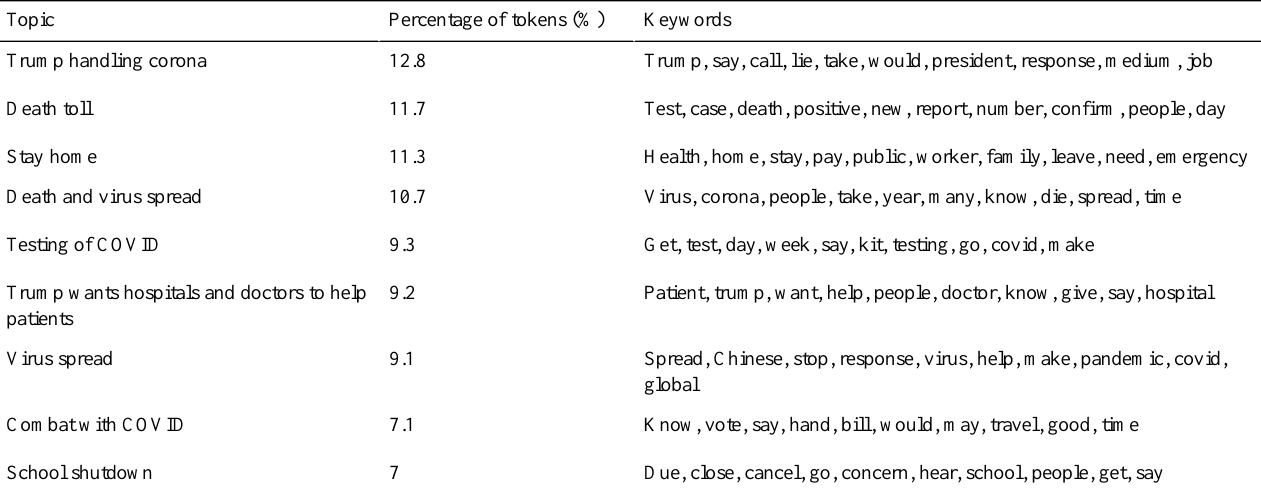
Table 1. Major topics discussed based on COVID-19 tweets posted by e-cigarette users (Ecig group) in the US, from March 5, 2020, to April 3, 2020. KeywordsPercentage of tokens (%)Topic